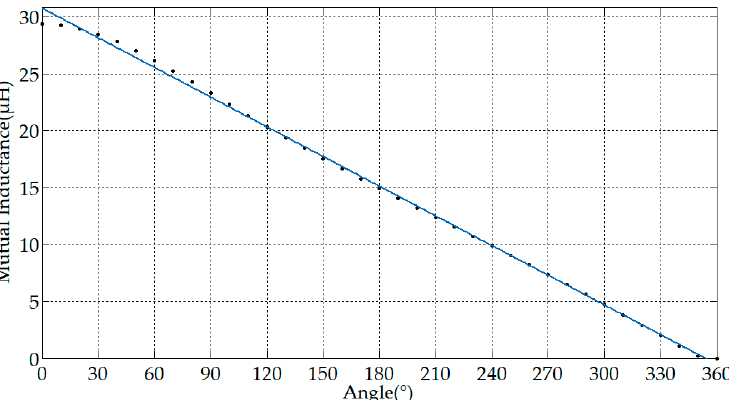
Figure 12. The relationship between distribution angle and mutual inductance.